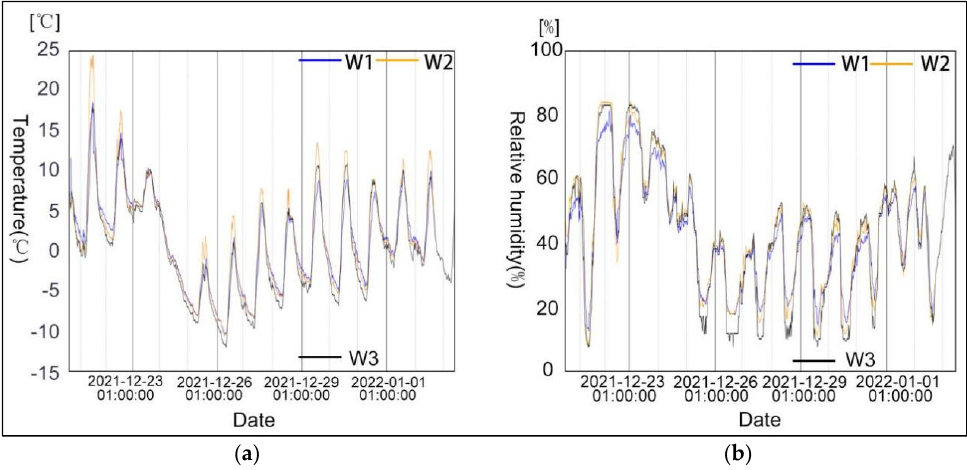
Figure 15. Outdoor environmental parameters in winter: ( a ) air temperature; ( b ) relative humidity.